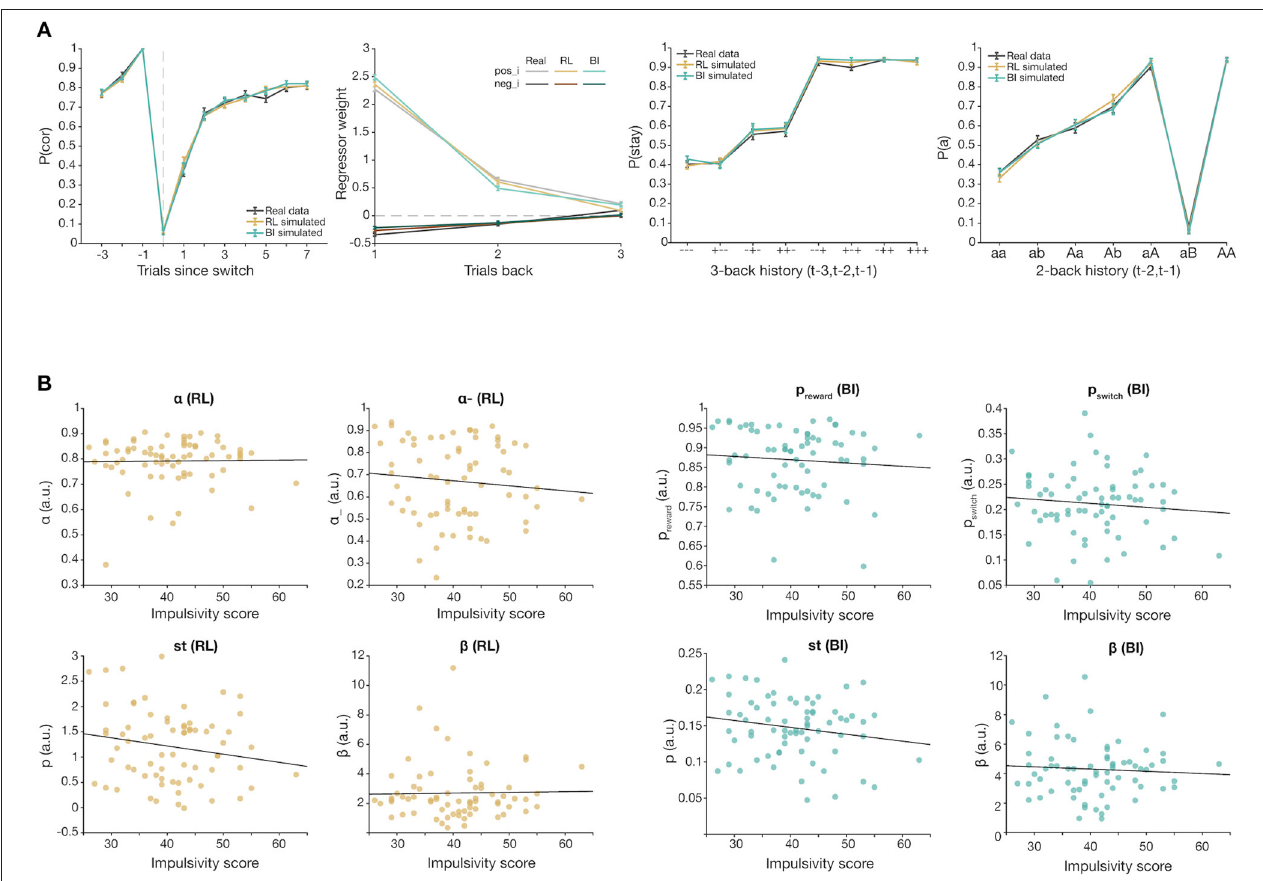
FIGURE 5 | Computational modeling results of best-fitting models, RL (brown) and BI (teal). (A) . Comparison of behavior simulated from best fitting models RL and BI, and real participant behavior (black). Both models capture group-level switching behavior. (B) Total impulsivity score vs. fit parameter values of RL (left) and BI (right) (all p s >